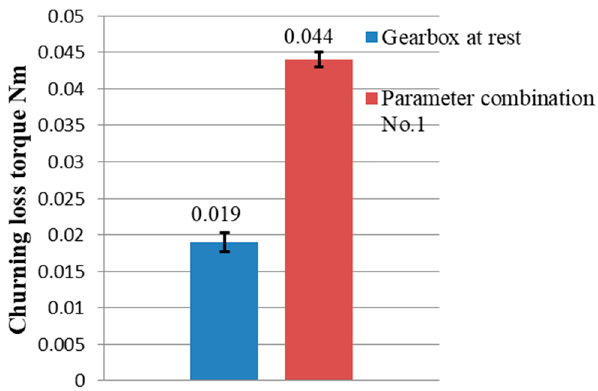
Figure 7. Average churning loss torque with and without motion of the gearbox.